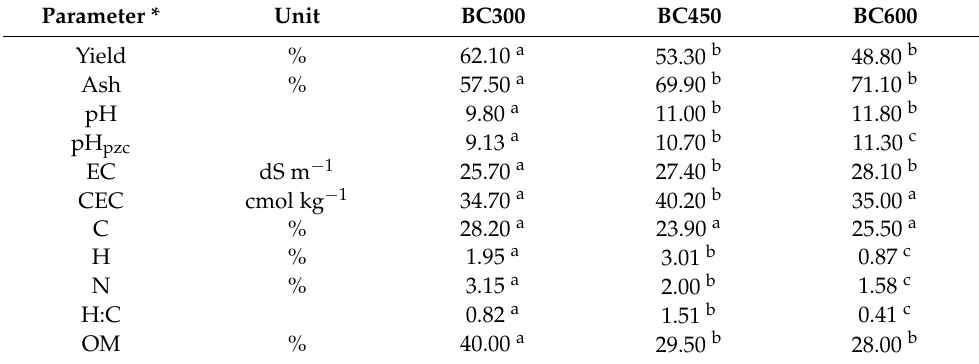
Table 1. Yield and physicochemical characteristics of biochar samples from Macrocystis pyrifera produced at different pyrolysis temperatures (300, 450, and 600 ◦ C). a–c Different letters indicate significant differences among biochar samples with p < 0.001 obtained by ANOVA with a posteriori Tukey test, n = 9–12. * EC, electric conductivity; CEC, cation exchange capacity; OM, organic